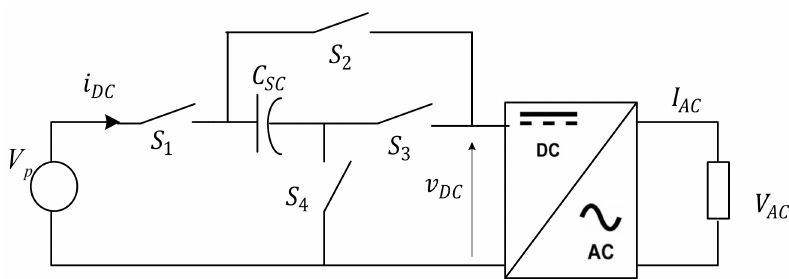
Figure 6. The switching arrangement of the SCAWI-PV